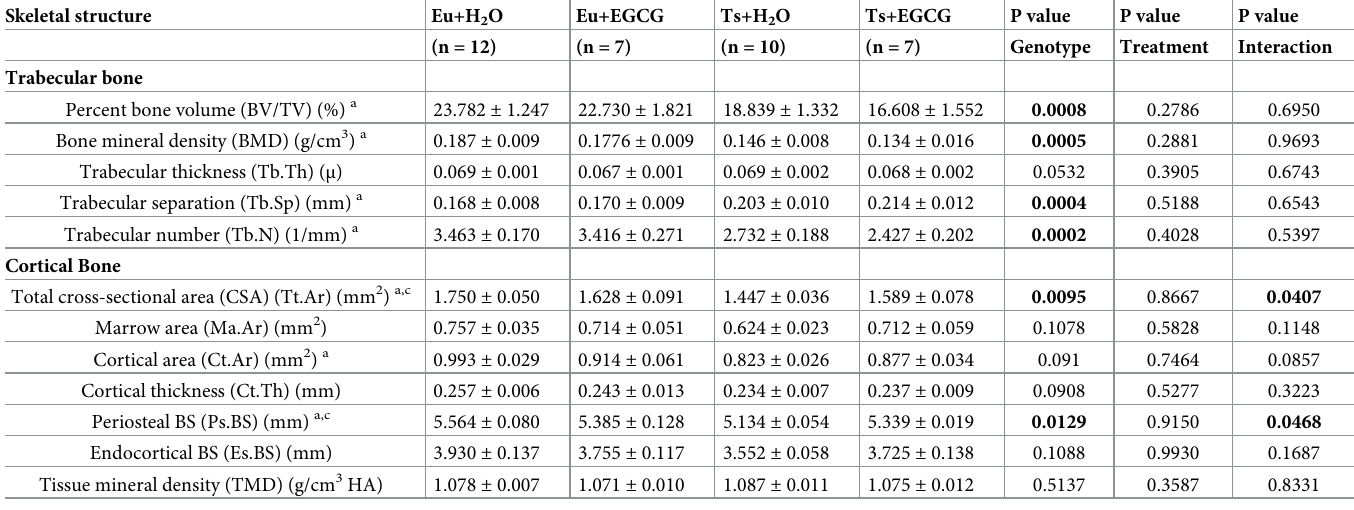
Table 2. Parameters of Skeletal Structure for Ts65Dn and Euploid mice treated with 20 mg/kg/day EGCG or vehicle (Average ± SEM; ANOVA